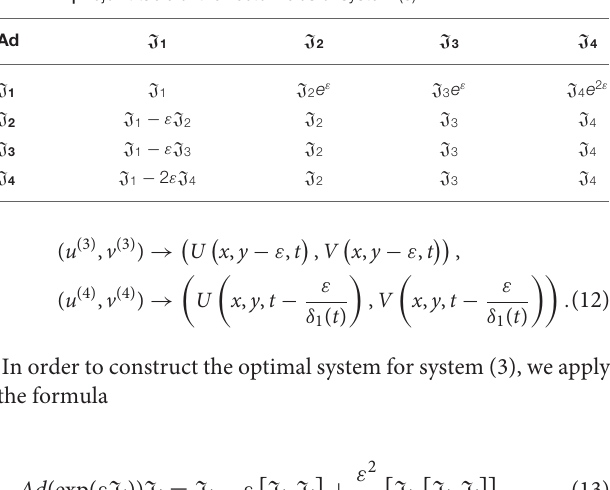
TABLE 2 | Adjoint table of the vector fields of system